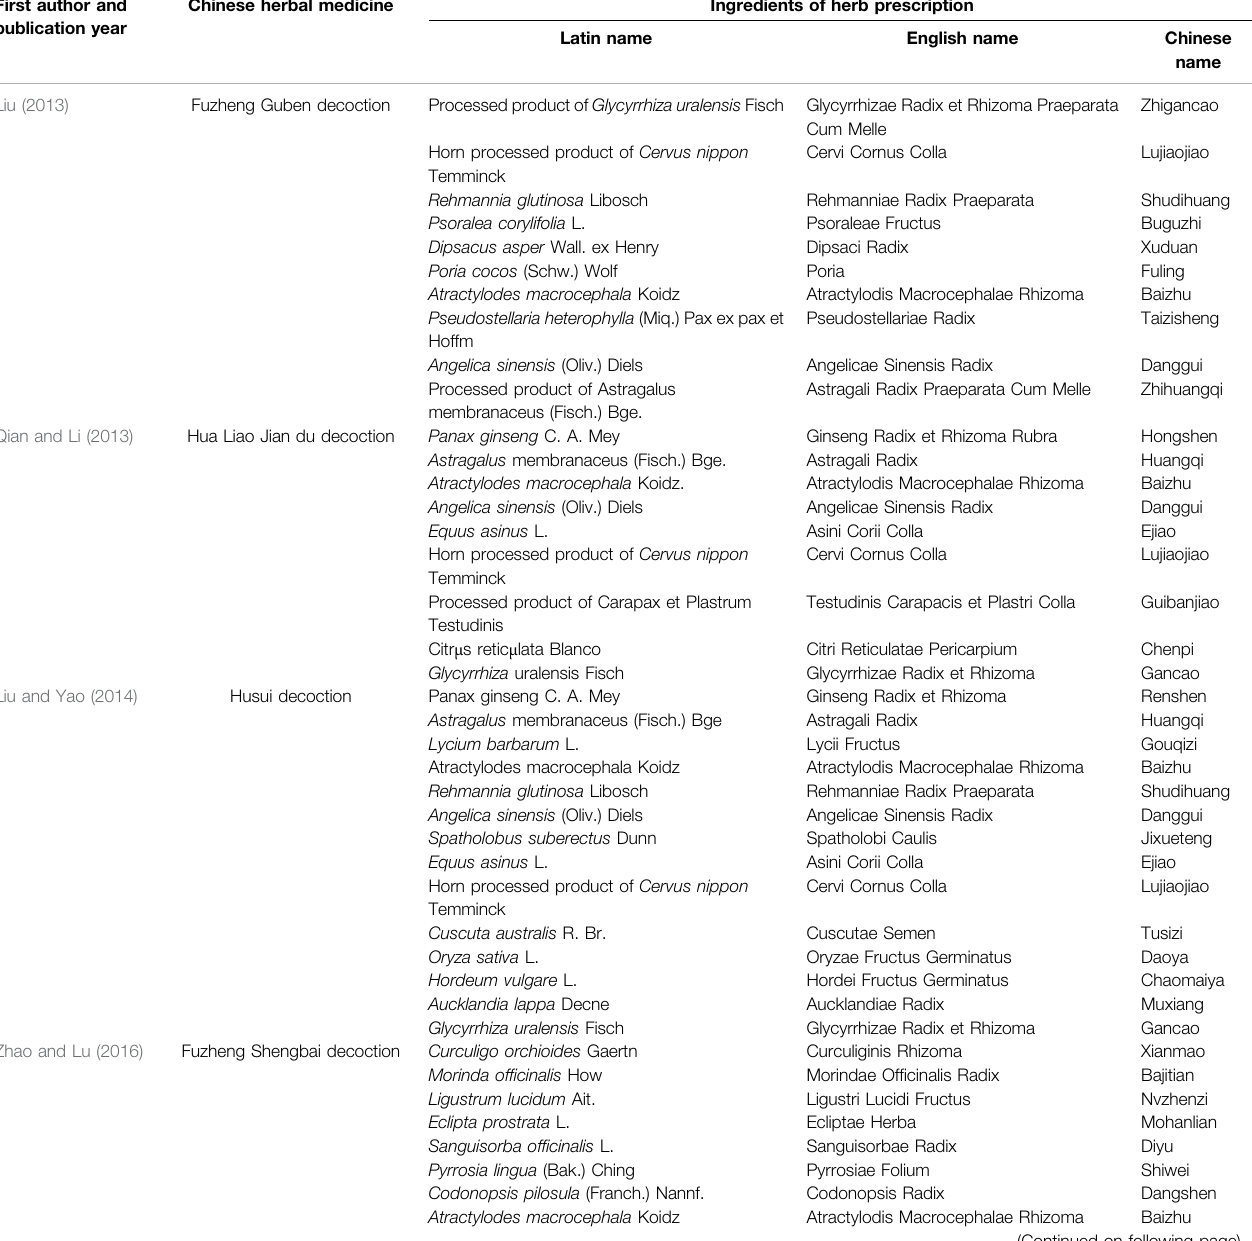
TABLE 2 | Components of Chinese herbal medicine used in the included